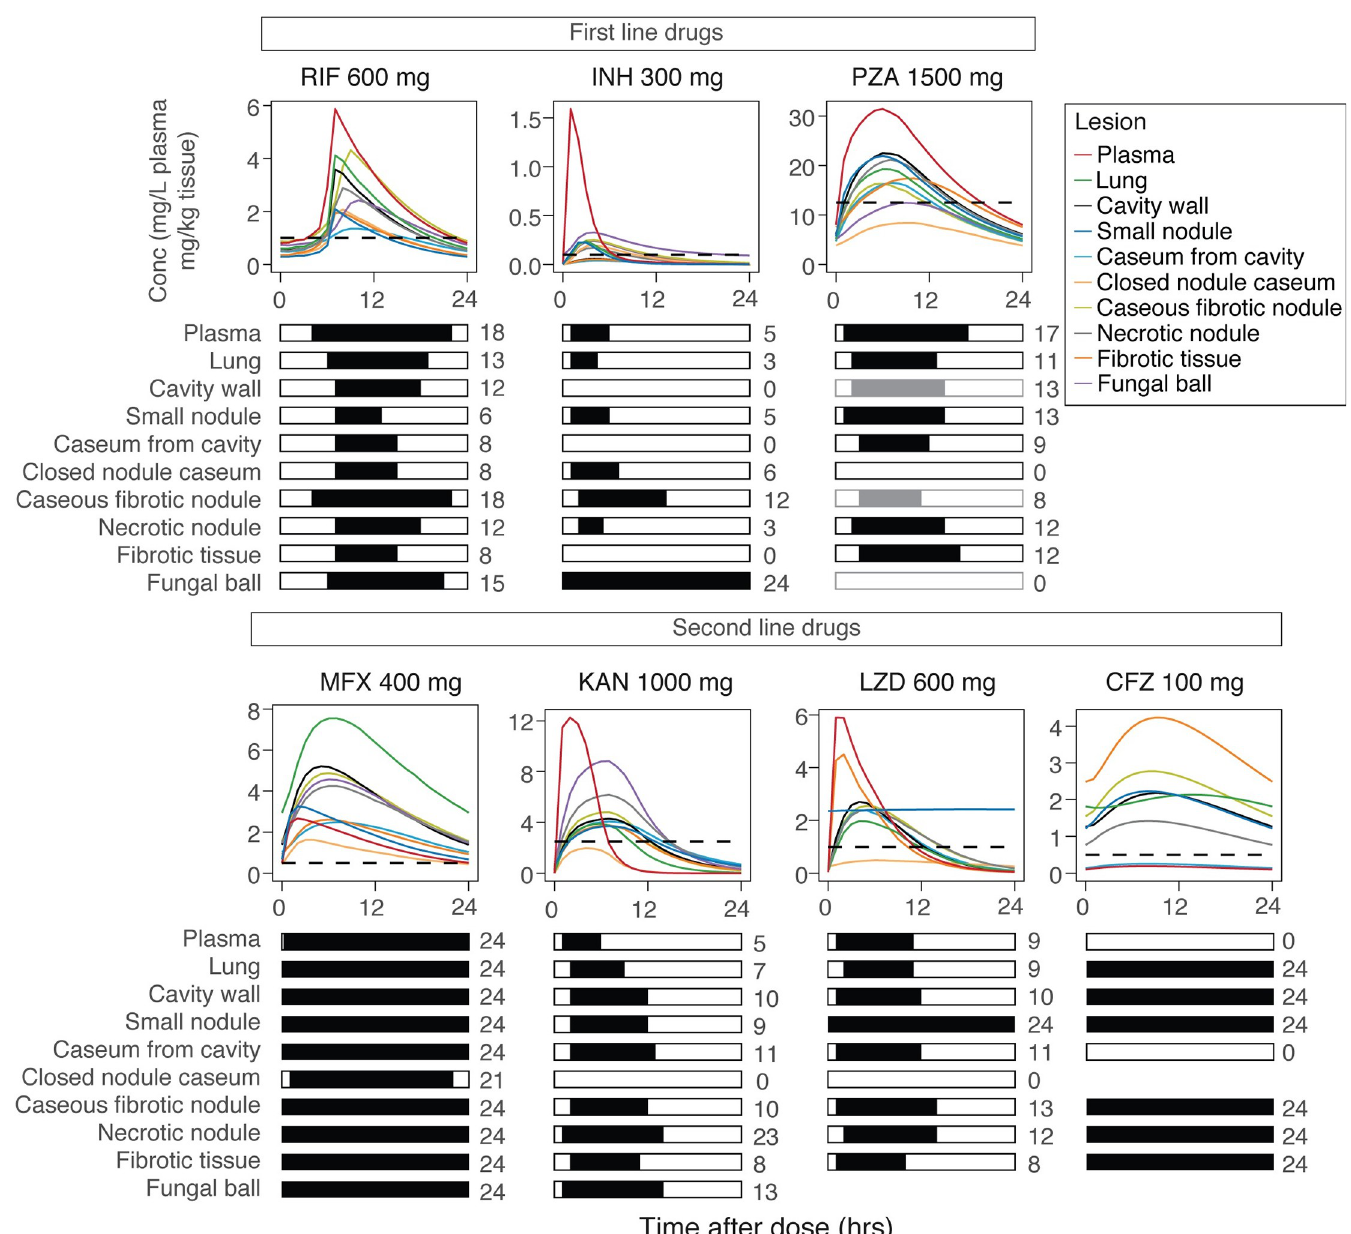
Fig 5. PK profiles of individual drugs in at-risk patients relative to MIC. One thousand patients were simulated using the established model and the fifth percentile of lower exposure shown with facets for individual drugs to compare drug penetration into respective lesions shown by different colors. The dashed line in the concentration–time panel represents each drug’s respective MIC, and the bar graph below simplifies drug concentration above or below by black and white bars for each lesion. Additionally, the total time drug concentration is above MIC at steady state over 24 h is printed next to each respective bar. Importantly, PZA’s MIC of 12.5 mg/L is low-pH specific, which does not represent all the lesions’ pH environment. For the lesions with likely higher pH environments and assumed less PZA activity, gray bars instead of black bars are used to indicate drug concentration above MIC. MIC, minimum inhibitory concentration; PK, pharmacokinetic; CFZ, clofazimine; INH, isoniazid; KAN, kanamycin; LZD, linezolid; MFX, moxifloxacin; NA, not available; PZA, pyrazinamide; RIF,